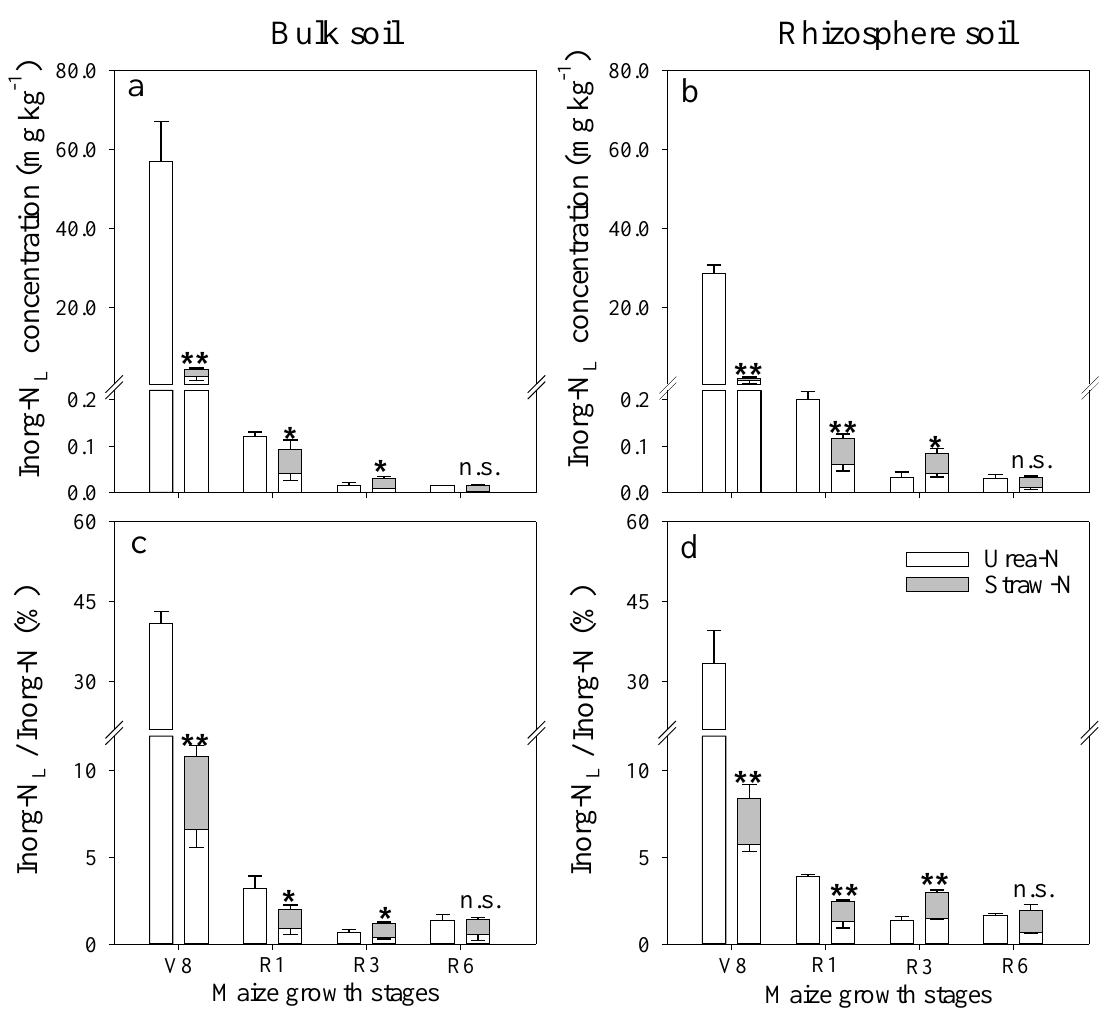
Figure 4. Concentration ( a , b ) and percentage ( c , d ) of labeled applied N (N L ) present as inorganic N (Inorg-N) in bulk and rhizosphere soil in different fertilizer treatment during maize growth. White-only bars represent urea treatment (U). White plus gray bars represent urea combined with straw treatment (US). Maize growth stage: V8, R1, R3, and R6 respectively represent 8th leaf stage, silking stage, milk stage, and physiological maturity. Data shown are mean ± standard deviation of three replicates; * and ** denote significant differences at p < 0.05 and p < 0.01, respectively; n.s., not significant ( p > 0.05).